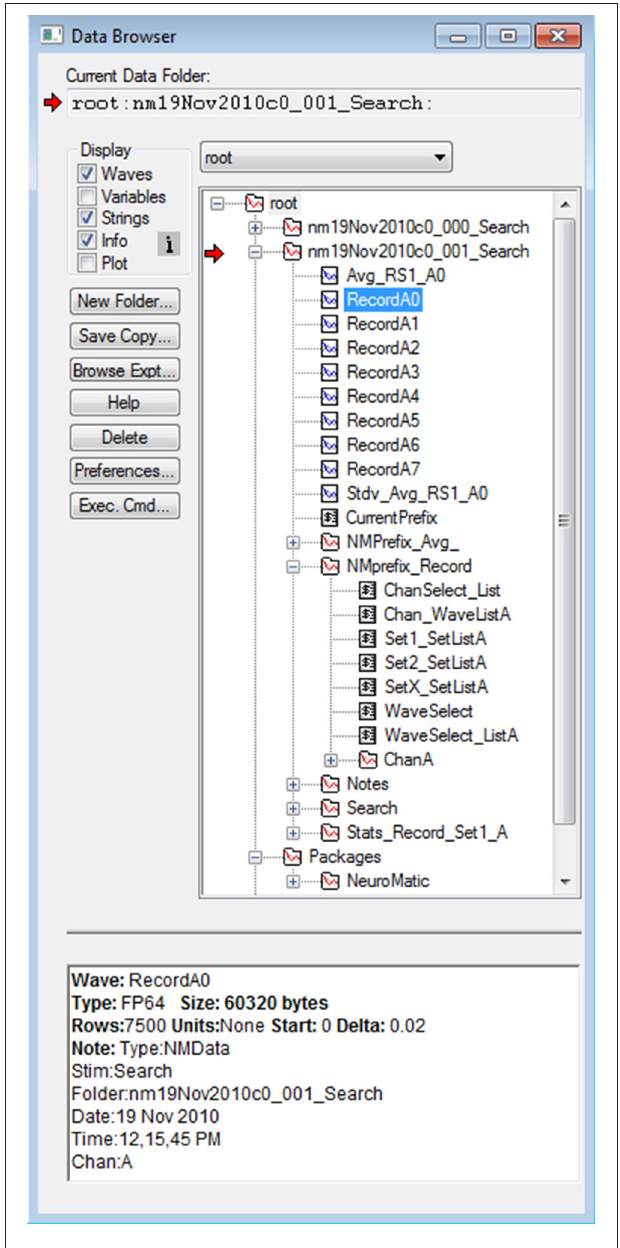
FIGURE 4 | NeuroMatic’s hierarchical folder structure . Screen capture of Igor’s Data Browser (Menu/Data/Data Browser), a useful tool for navigating through NeuroMatic’s data folder hierarchy. Here, all folders and variables were created by NeuroMatic inside Igor’s local-memory root directory. The top two folders beginning with “nm” were created by the Clamp tab after executing a stimulus protocol called “Search.” Red arrow denotes the folder selected for processing ( Figure 2 , control 1) which was clicked open for browsing. Inside the folder are waves with prefix “Record” and channel letter “A,” and a string variable CurrentPrefix containing the value of the wave-prefix select ( Figure 2 , control 2) whose current value is “Record,” in which case the prefix